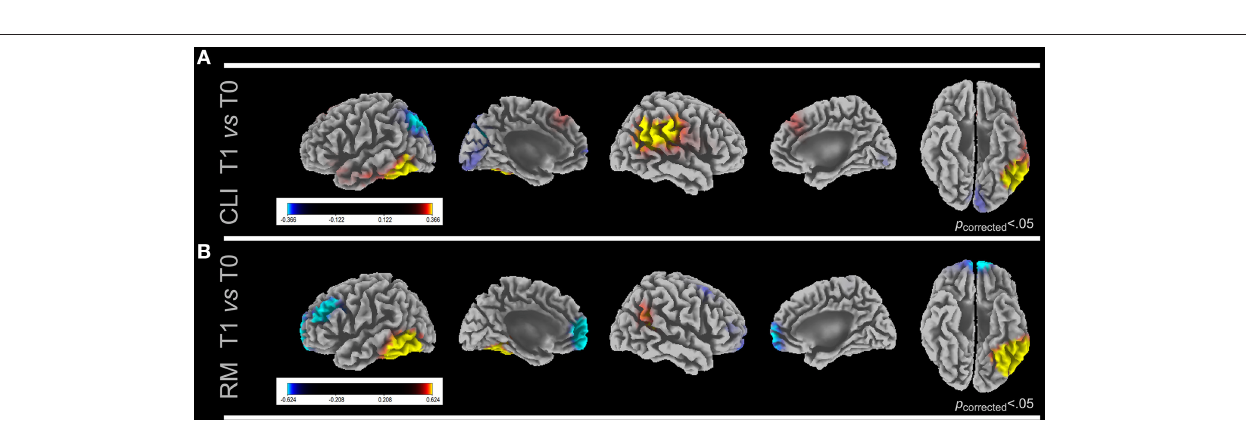
FIGURE 2 | LORETA images show cortical activation differences in gamma band between first (T0) and last (T1) sessions in CLI (A) and RM (B). Five views of the brain (lateral and medial left hemisphere, lateral and medial right hemisphere and ventral view) are shown for each comparison. Significant F -values (Bonferroni corrected) are reported. F -values colored scale is also shown for each comparison. yellow, first group > second group; blue, second group > first group. In (A) only the cluster depicted by yellow scale were found to be significant. CLI, All Clients; RM, Rome Clients; SGP, San Giuliano di Puglia